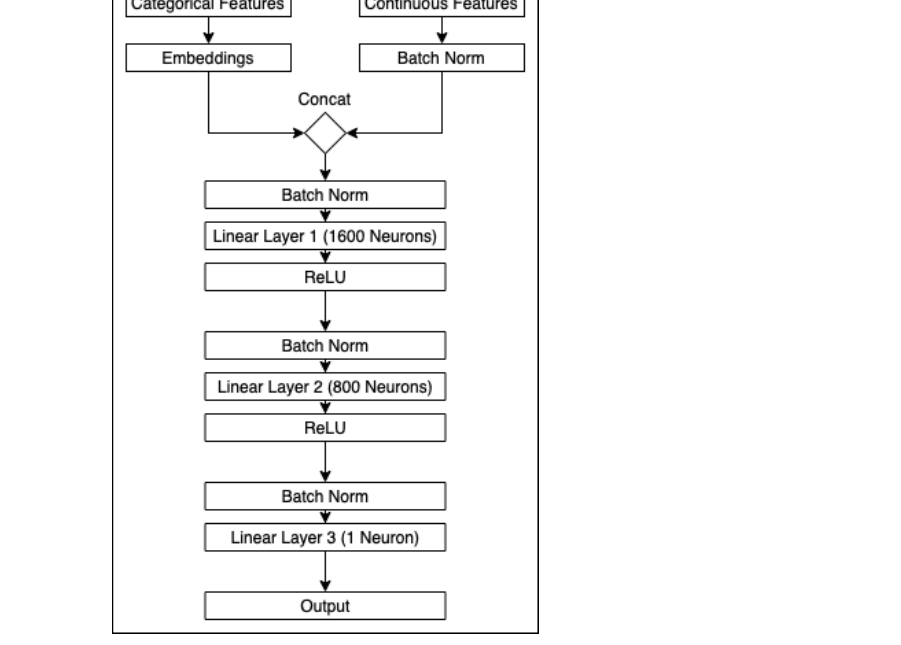
Figure 1. Diagram of the FastAI architecture. When we reference a model such as [1600, 800], we refer to a model with 1600 neurons in linear layer 1, 800 neurons in layer 2, and 1 neuron in layer